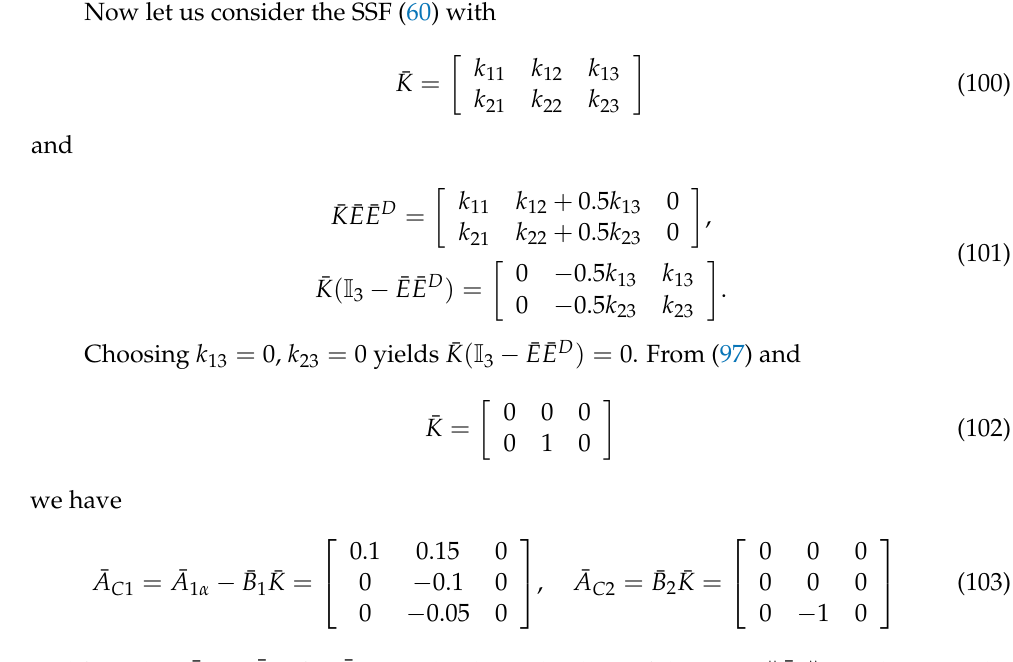
Figure 1. The state vector norms of the DDFL system (1) with α = 0.4 and (93) for x 0 = [ 1 4 2 ] and different values of L